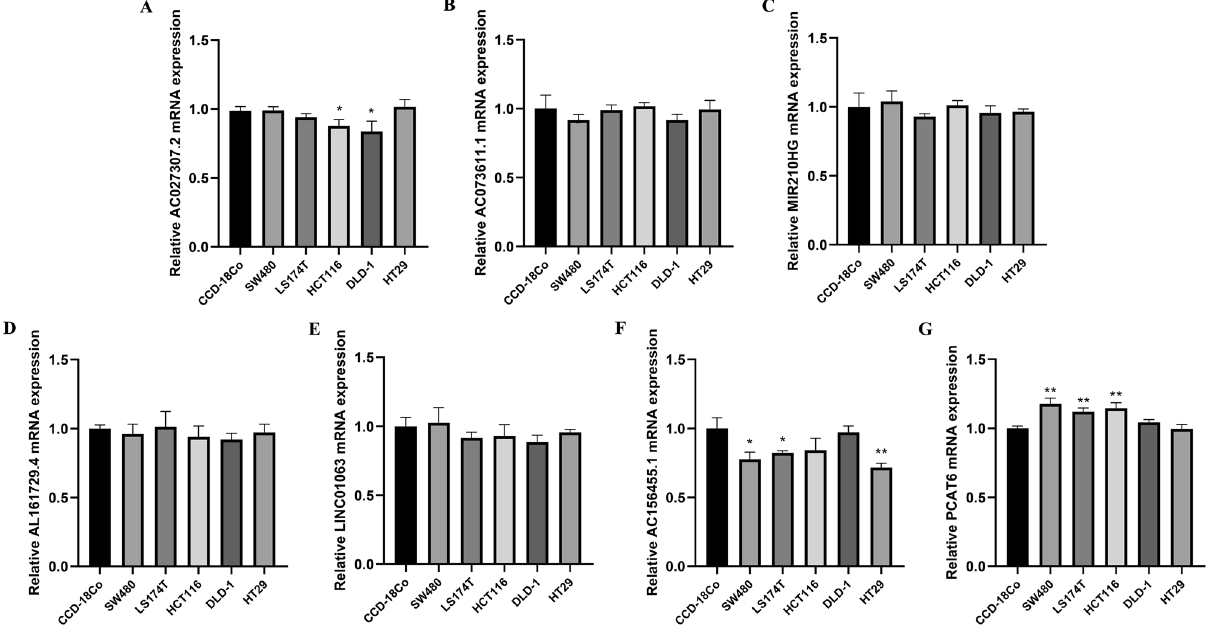
Figure 8. The qPCR result of seven lncRNAs in five COAD and normal colon mucosal epithelial cell lines. ( A ) qPCR result of AC027307.2; ( B ) qPCR result of AC073611.1; ( C ) qPCR result of MIR210HG; ( D ) qPCR result of AL161729.4; ( E ) qPCR result of LINC01063; ( F ) qPCR result of AC156455.1; ( G ) qPCR result of